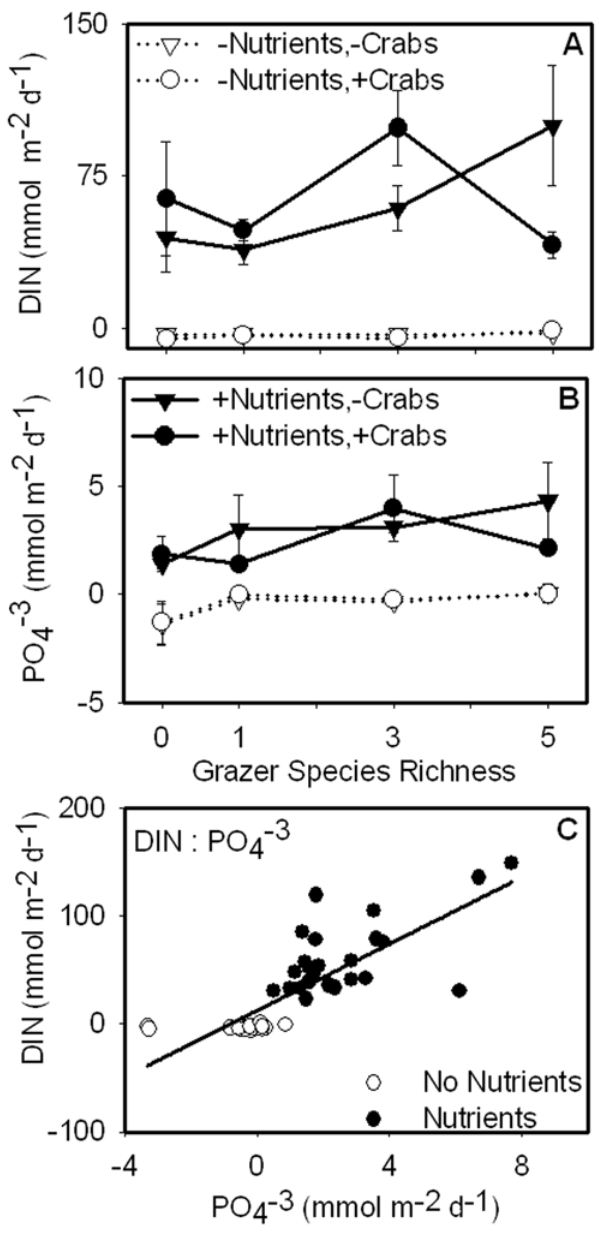
Figure 6. Daily flux rates of DIN and PO 4 2 3 . Nutrient enrichment increased daily flux rates of DIN and PO 4 2 3 (A–B). DIN and PO 4 2 3 were positively correlated (r 2 =0.64; p , 0.001; C). The equation of the line was: y=15.47x + 11.85.